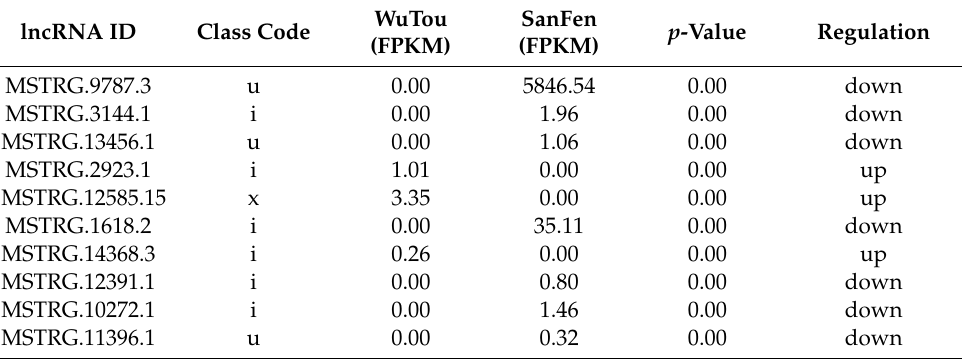
Table 3. The top 10 most significantly expressed lncRNAs of gluteus muscle. lncRNA ID Class